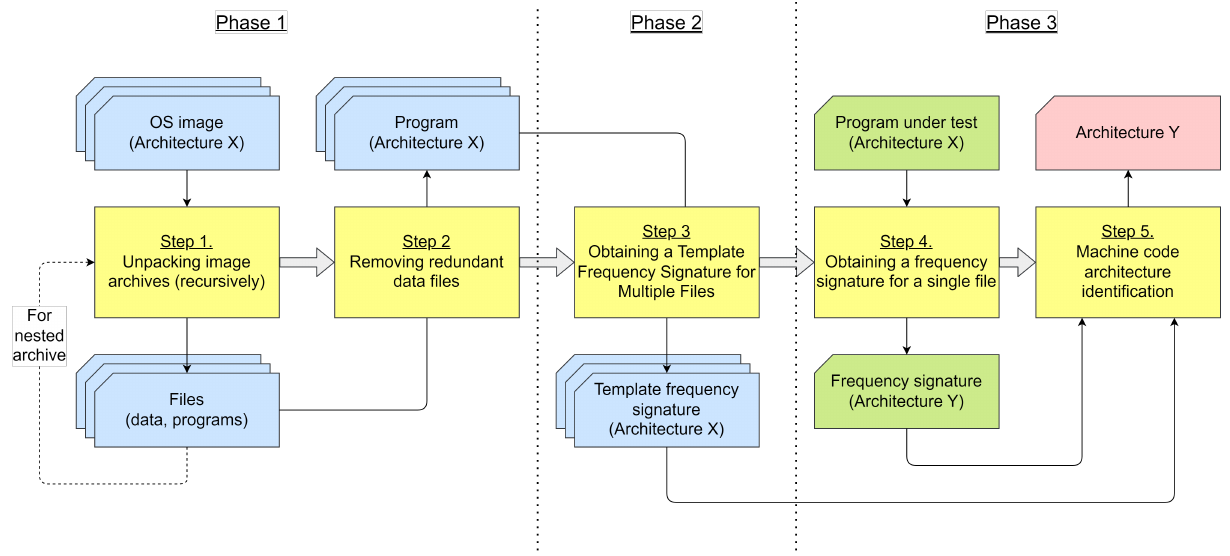
Figure 3. MC Architecture Identification Method Diagram. Note. In the figure, a set of objects (OS images, Signatures, etc.) is represented using figures arranged one after another, i.e., by introducing a z -axis going into the depth of the circuit. In addition, the following colors of the background of the forms were used: yellow—Method steps, blue—information independent of the tested program, green—information about the tested program, red—the result of